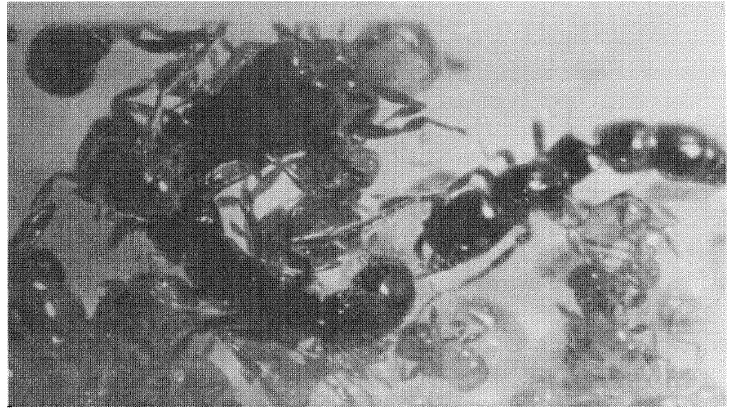
Figure 3. Cerapachys raiding group invading a Pheidole